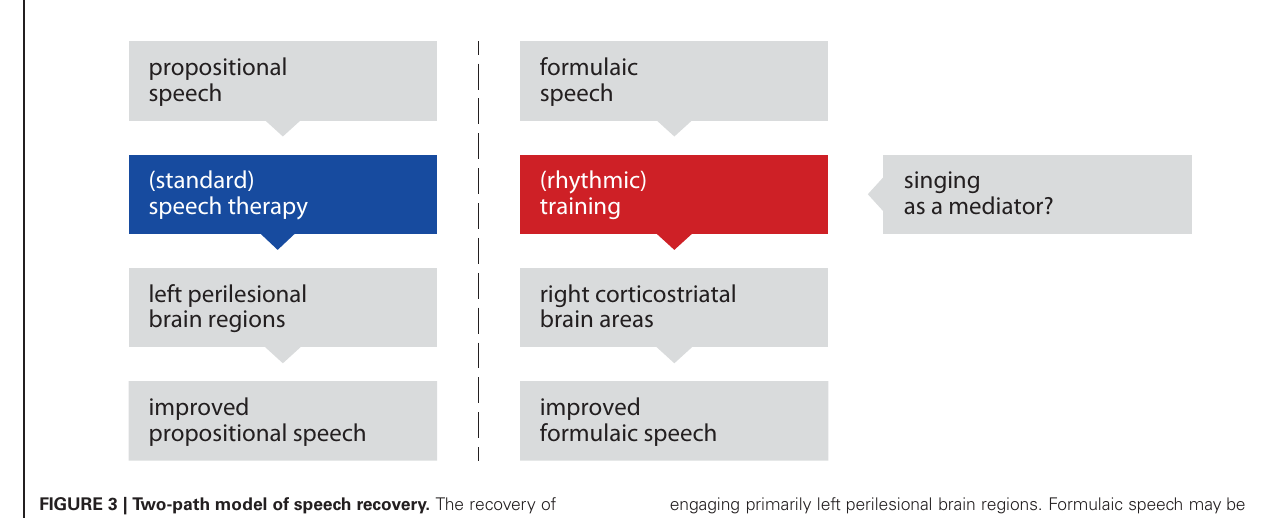
FIGURE 3 | Two-path model of speech recovery. The recovery of propositional and formulaic speech may rely on different neural pathways. Propositional speech may be improved through standard speech therapy,